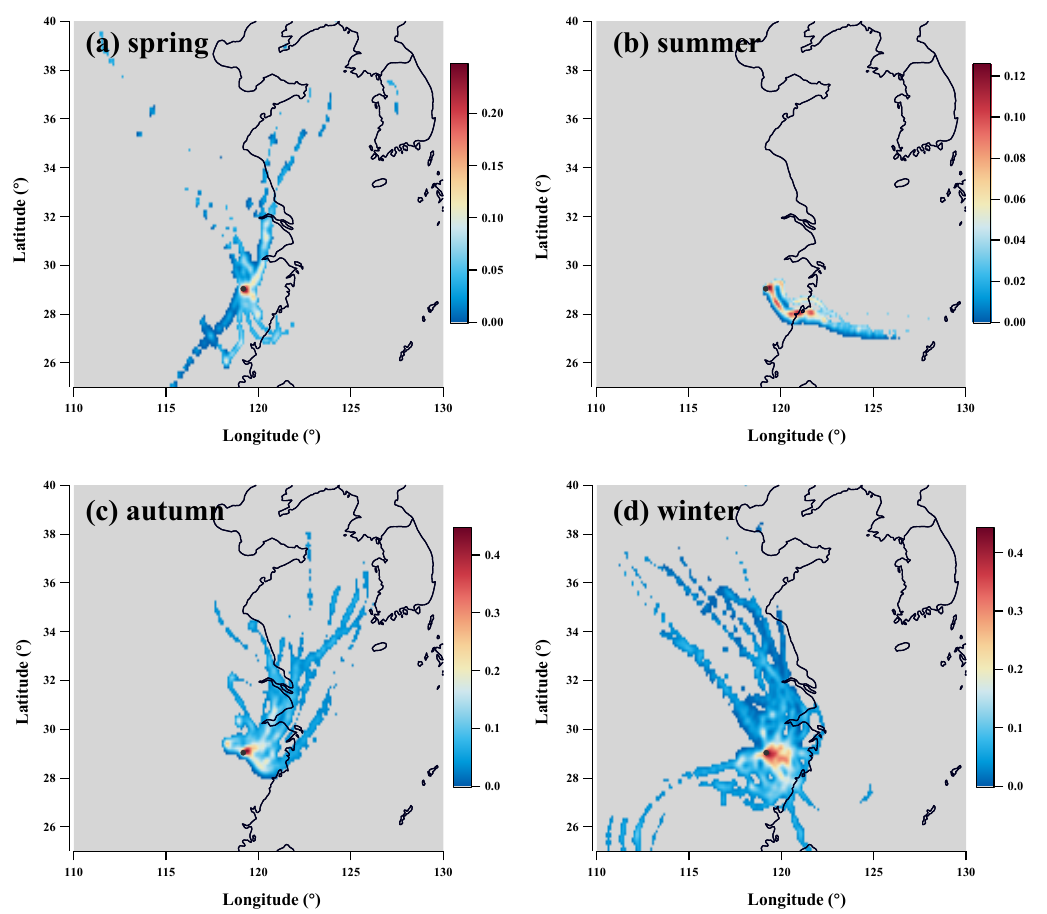
Figure 9. The simulation results of the WPSCF during the sampling periods of ( a ) spring, ( b ) summer, ( c ) autumn, and ( d ) winter.